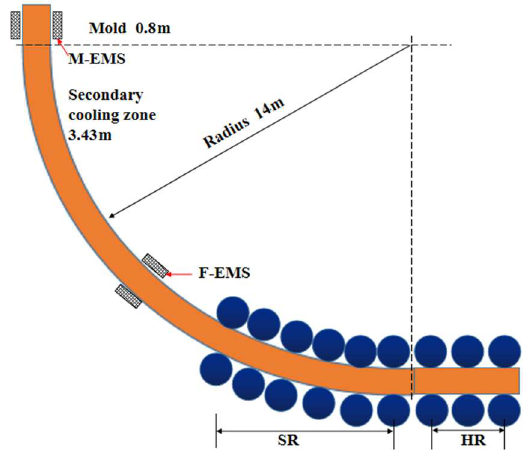
Figure 1. Schematic diagram of the bloom continuous caster.